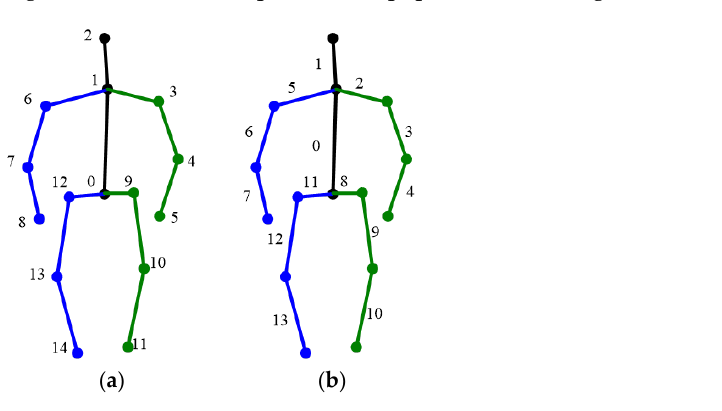
Figure 1. Three-dimensional pose model in this paper. ( a ) Three-dimensional keypoints; ( b ) bone segments. Keypoints: 0 Waist, 1 Neck, 2 Head, 3 Left Shoulder, 4 Left Elbow, 5 Left Wrist, 6 Right Shoulder, 7 Right Elbow, 8 Right Wrist, 9 Left Hip, 10 Left knee, 11 Left Ankle, 12 Right Hip, 13 Right Knee, 14 Right Ankle.